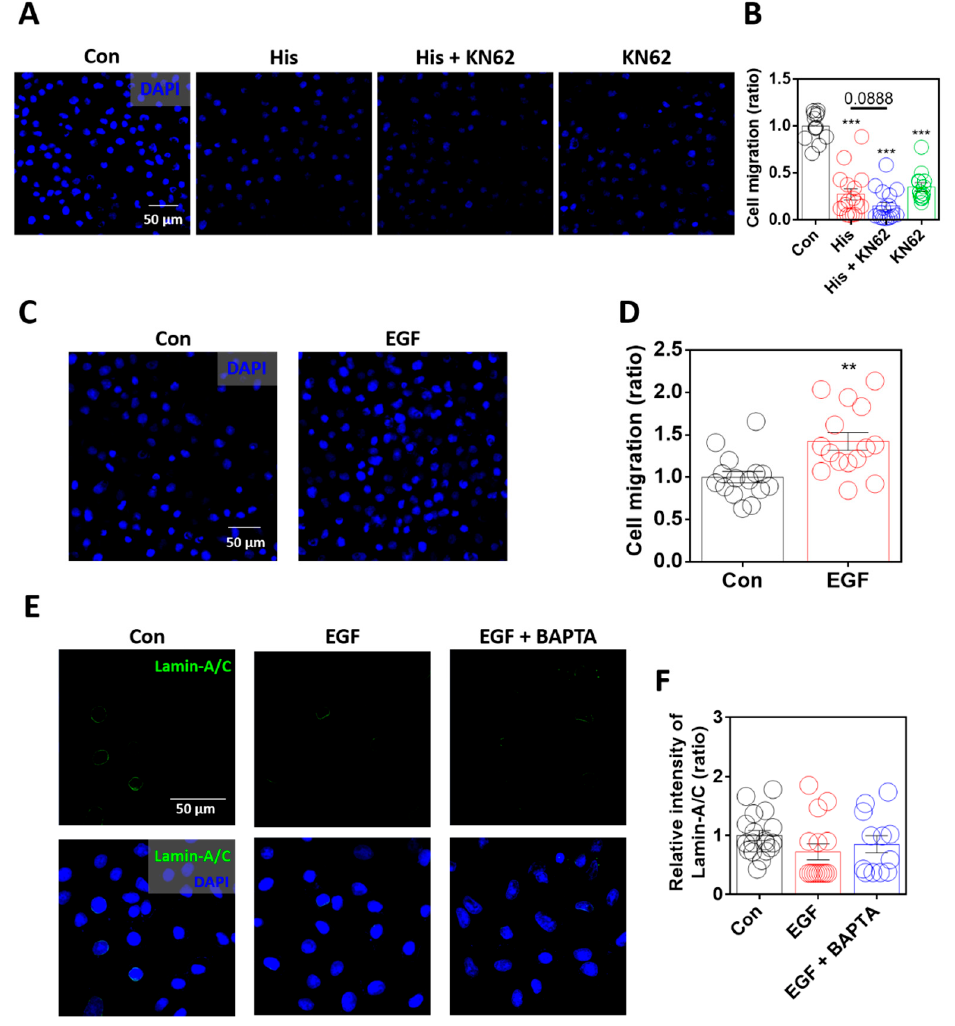
Figure 6. Enhanced lamin-A/C expression was associated with reduced cellular motility. ( A ) Im- munofluorescence staining of DAPI (blue) after histamine (His) treatment (100 µ M, 4 h) with or